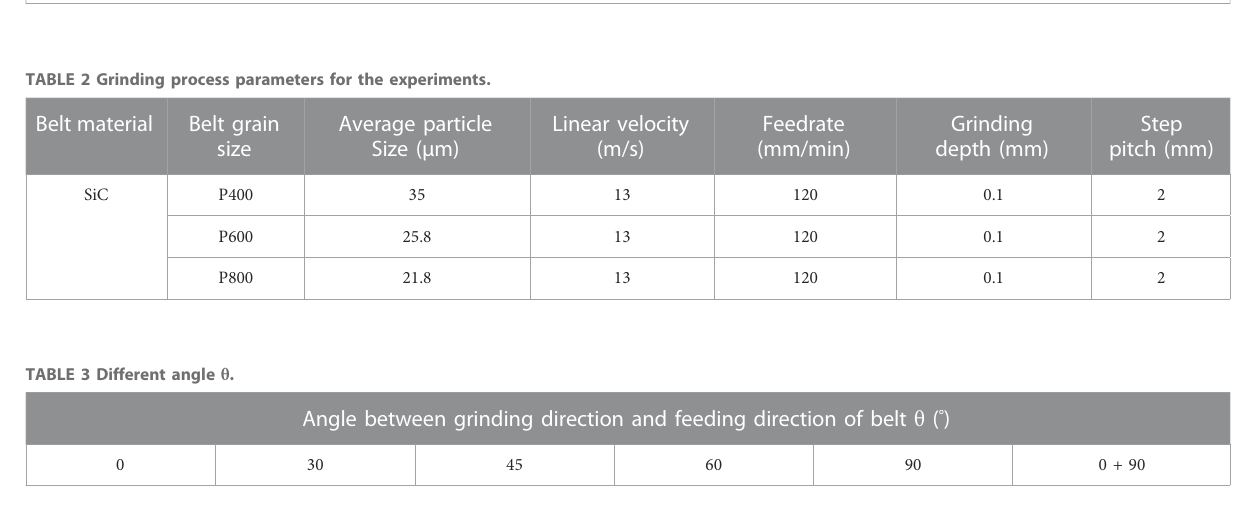
direction. The CNC sets the starting and ending points of the grinding trajectory. The machining parameters speci fi ed in Tables 2, 3 ( “ 0 + 90 ” stands for grinding at θ = 0 ° and then covering with θ = 90 ° ) are used to obtain a schematic diagram of the grinding trajectory for the blade test. Figure 2 illustrates the entry point, exit point, and movement path of the abrasive belt contact wheel, along with the actual grinding trajectory. The sample is fi xed to the machine ’ s motion platform with a fi xture during the grinding